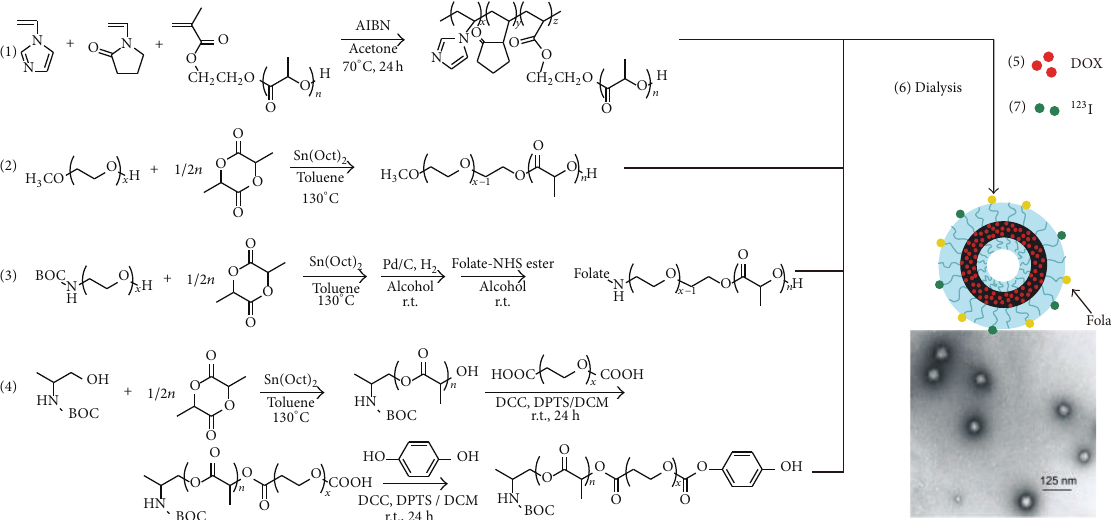
Figure 7: Representation of multifunctional hollow nanoparticles and their TEM image. Reprinted from Biomaterials, 2011, 32,